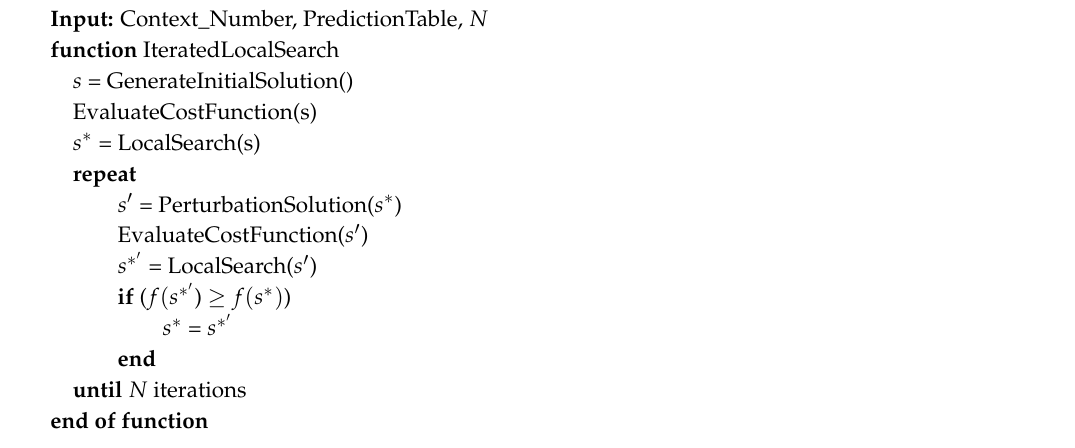
Algorithm 1: Iterated Local Search algorithm for context distribution of sign